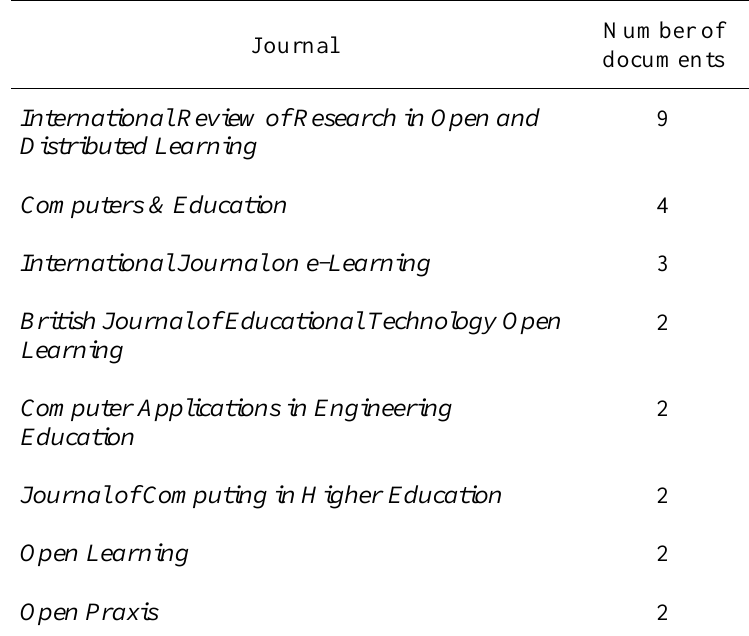
Main Publication